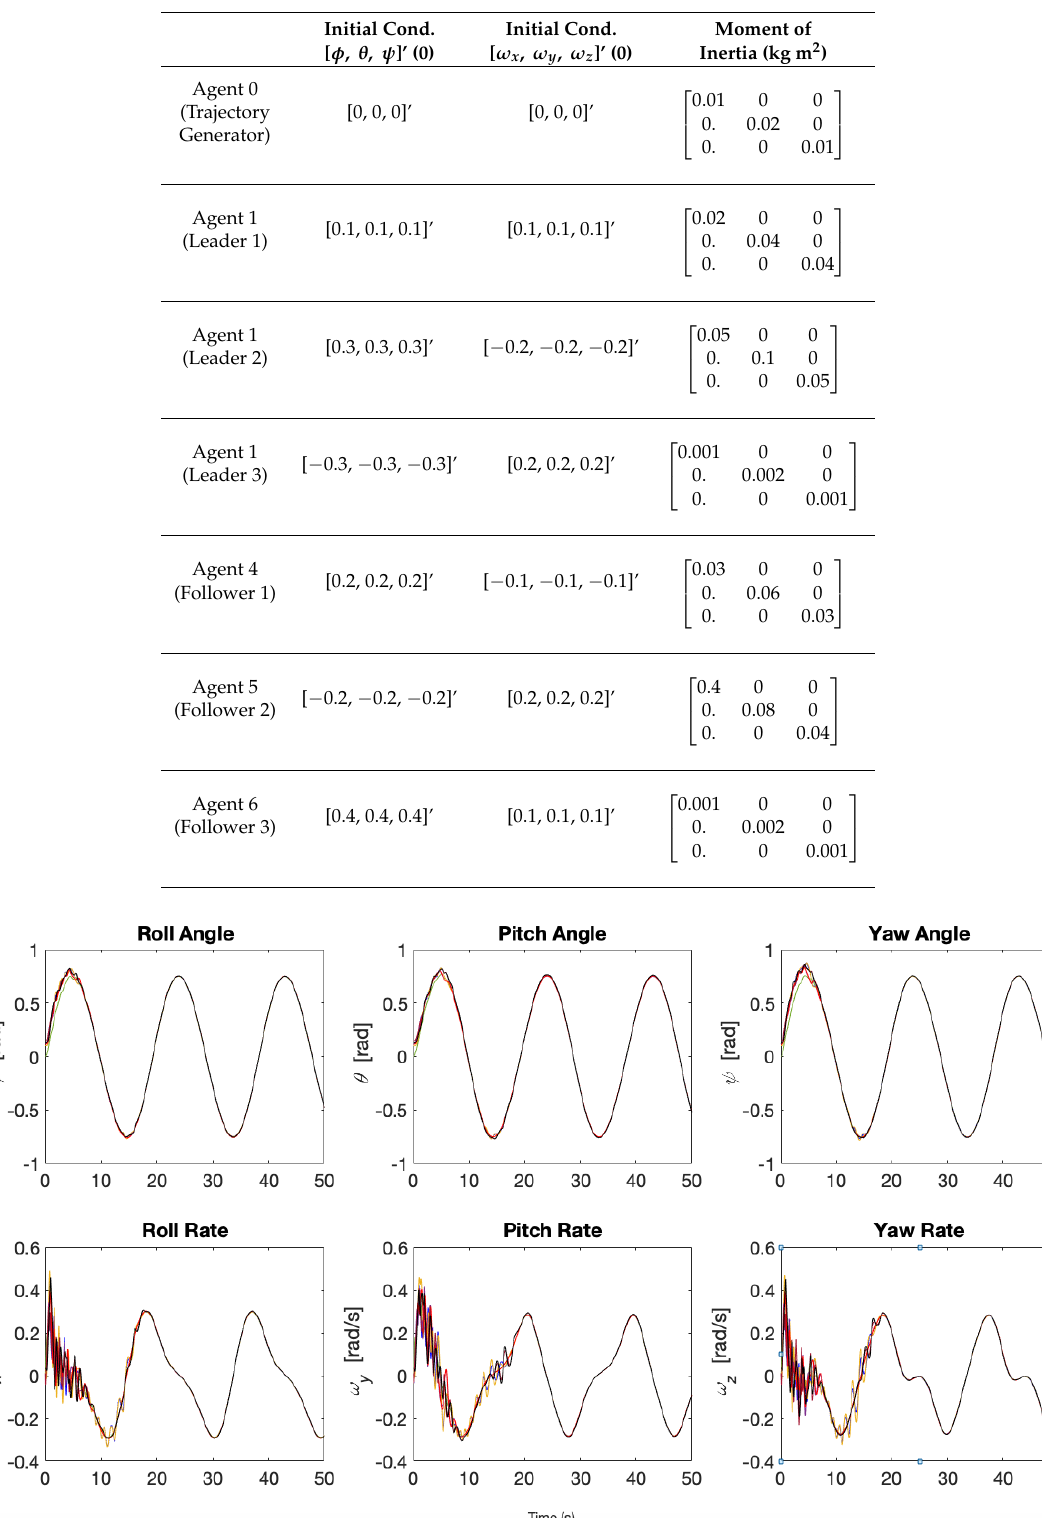
Table 1. Satellite parameters and initial conditions.